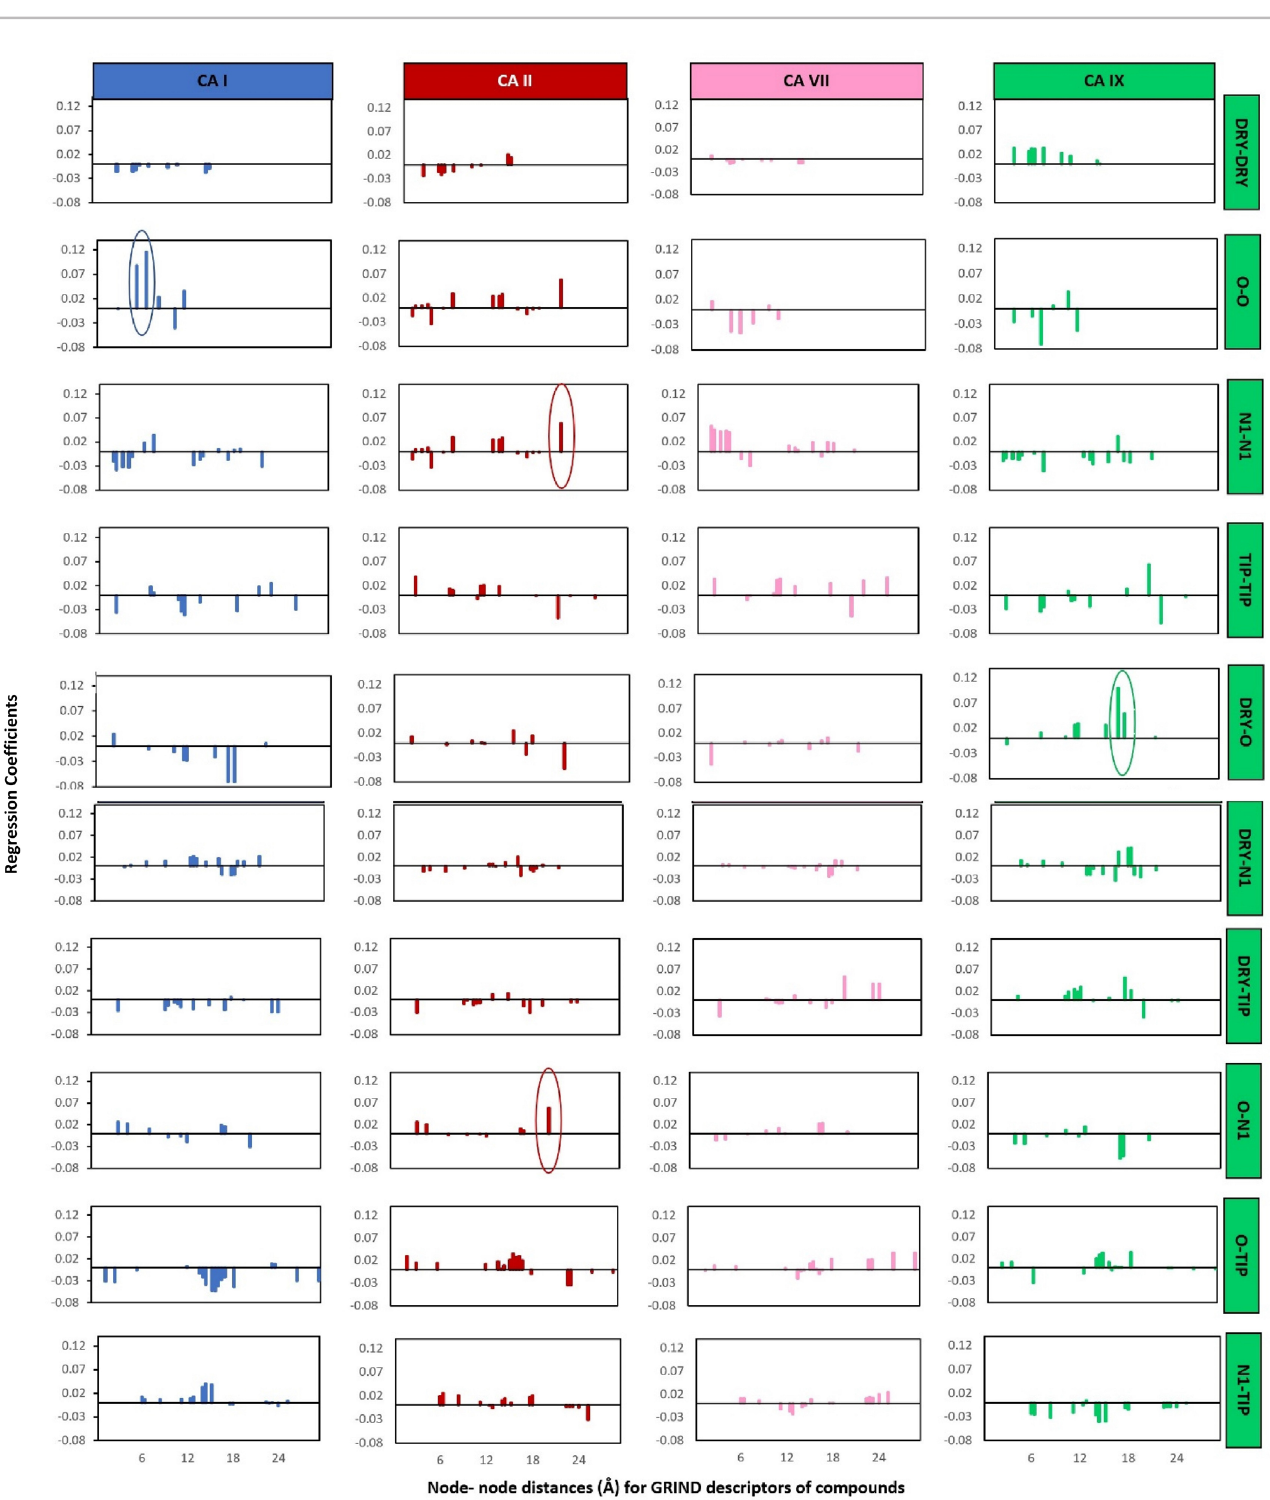
FIGURE 5 - Overall representation of GRINDs contribution in receptor selectivity. Y-axes indicate the regression coefficients. Intervals separated by dashed vertical separators represents the node-node distance range of 0 Å to 29.2 Å for each type of GRIND. GRINDs which are highly discriminative with regard to a certain receptor are